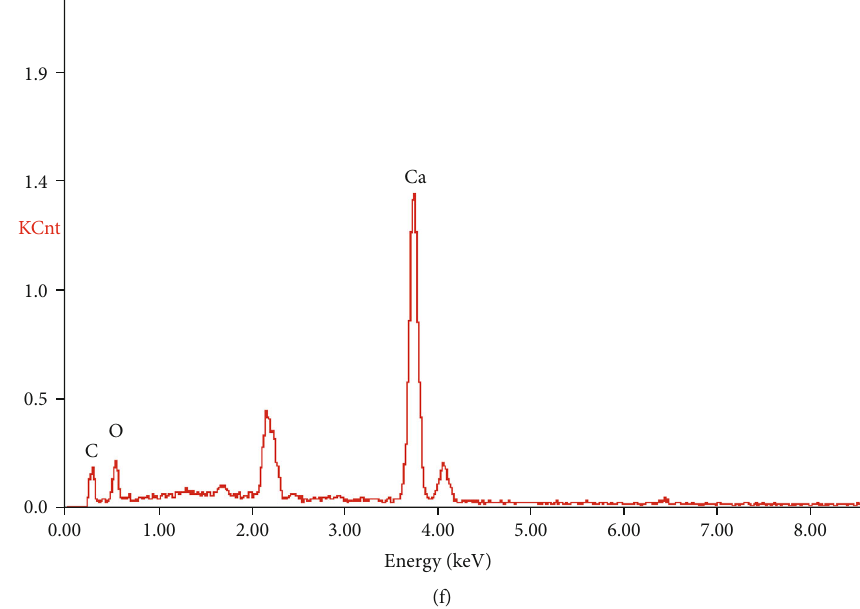
Figure 6: Fractures and minerals in coal. (a) Endogenous fractures, (b, d) endogenous fi ssures fi lled with clay minerals, (c, d) clay minerals, (e) endogenous fractures fi lled with carbonate minerals, and (f) results of the elemental analysis of the point marked by the red cross in (e).